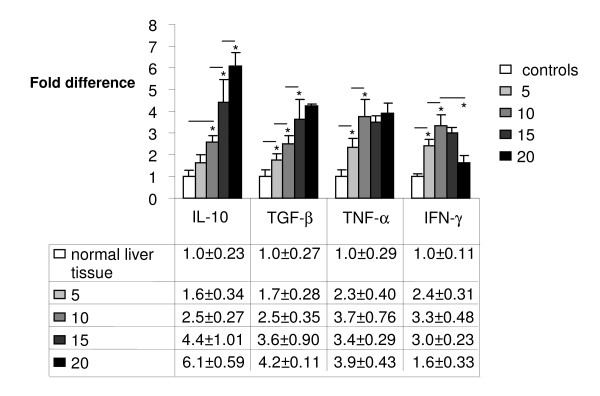
Real Time PCR: Significantly increasing gene expression of IL-10, TGF-β, TNF-α but a decrease of IFN-γ at metastatic sites in the liver on day 10, 15 and 20 after intraportal injection of 1 × 105 CT26.WT cells. Analysis was measured to control tissue (liver). Lines with asterisks show significant differences during metastatic growth.